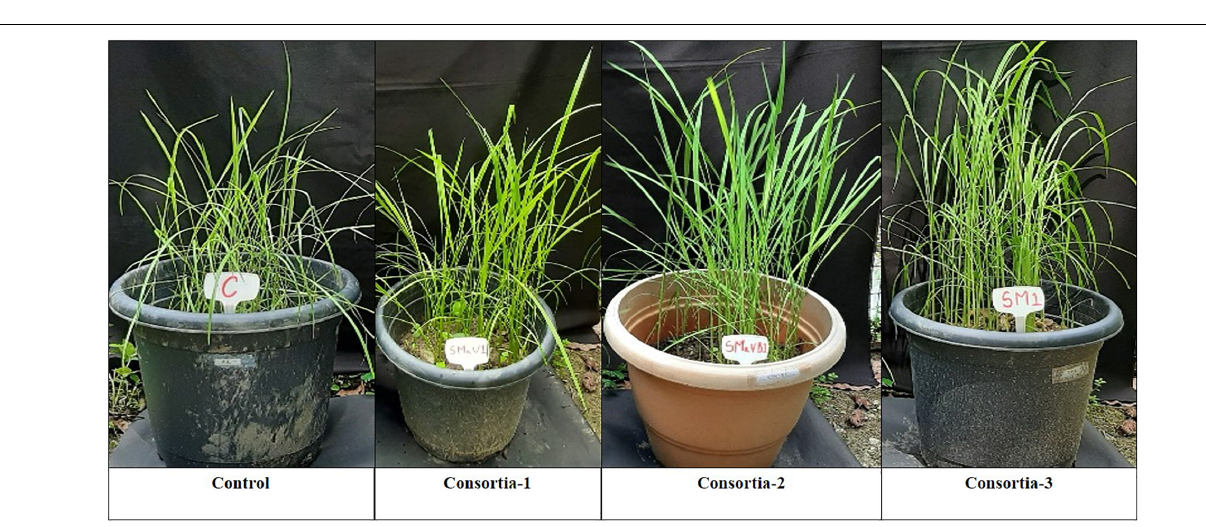
FIGURE 4 | Phenotype differences of potted rice plant under different consortia treatments. Consortia-1 (SRB+PSB1+COW3), Consortia-2 (PSB2+SRD+COW3), and Consortia-3 (COW3+KSB+YMA7), and control rice